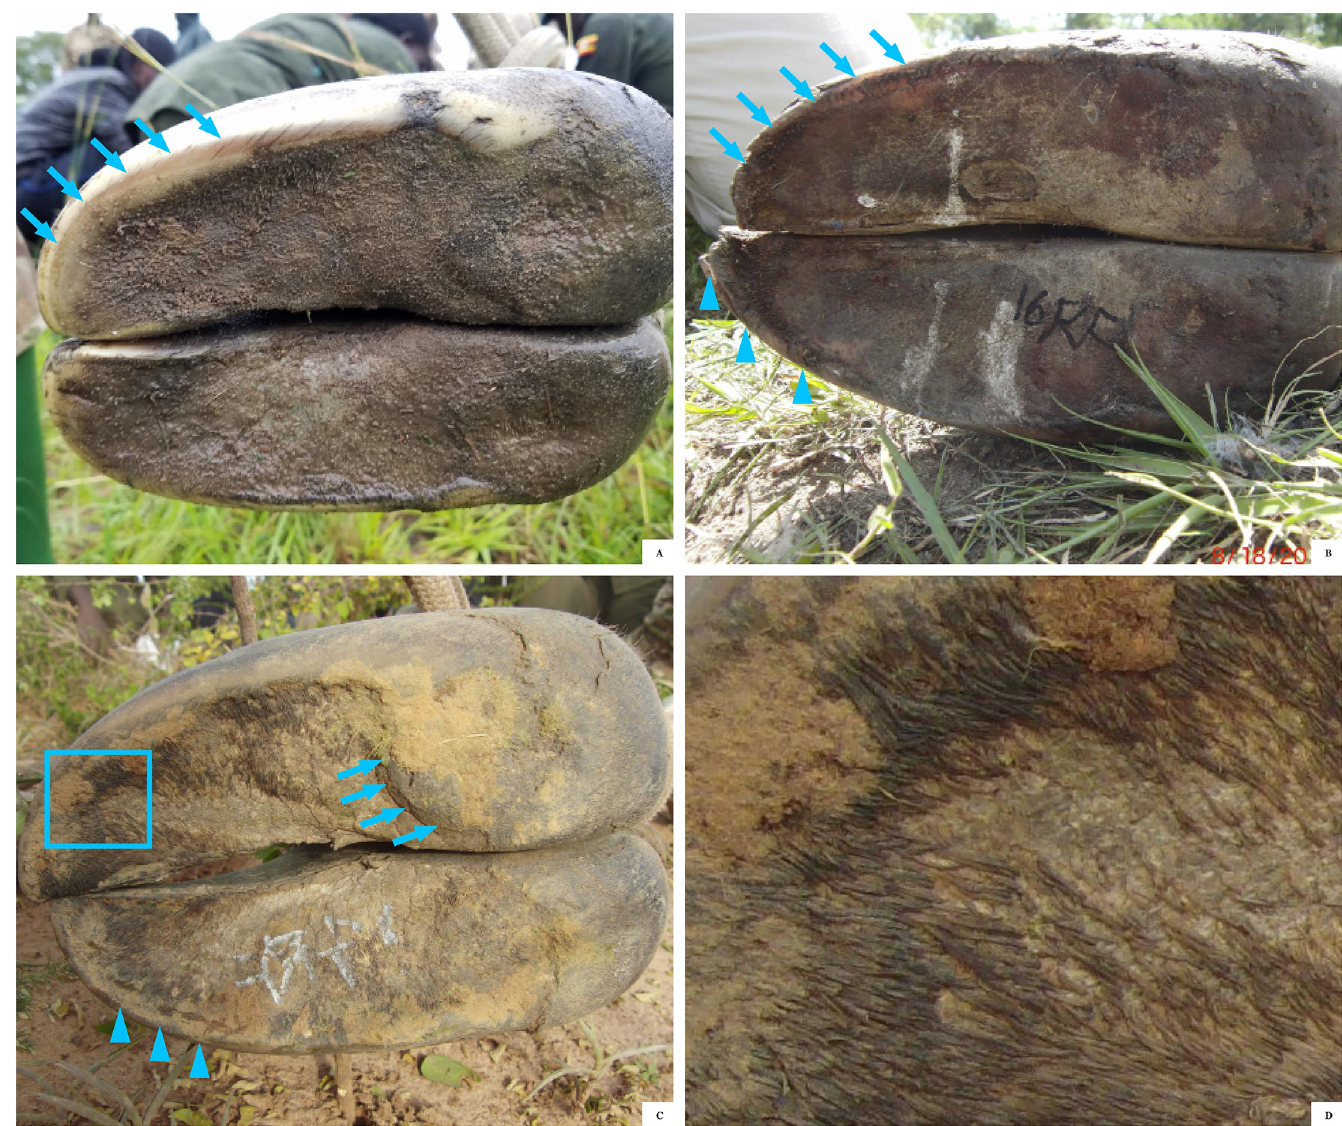
Fig 5. Solar views of giraffe front feet, demonstrating how hooves are self-maintained during the rainy season in Murchison Falls National Park, Uganda. (A) A well maintained balanced capsule and no hoof wall overgrowth. The wall at the toe tips and periphery ( " ) is worn to the same level as the sole. (B) A foot with mild hoof wall overgrowth by the toe tip still maintains good foot symmetry medially to laterally, but has a slightly overgrown lateral toe tip (blue triangles). The medial claw hoof wall ( " ) has broken or chipped off and is being worn off to the level of the sole. For the lateral claw, the hoof wall has grown beyond the level of the sole (blue triangles) and is starting to chip or break off. This suggests that many hooves are not getting much longer than moderate overgrowth before the process of exfoliation of the sole and breaking the hoof wall happens, which maintains the balance of the hoof capsule. (C) A foot with moderate overgrowth of the hoof wall, sole, and heel ( " ). This foot has prominent sole papillae ( □ ). (D) Close-up of sole papilla from 5C, which have a hair-like projections as the sole starts to overgrow.